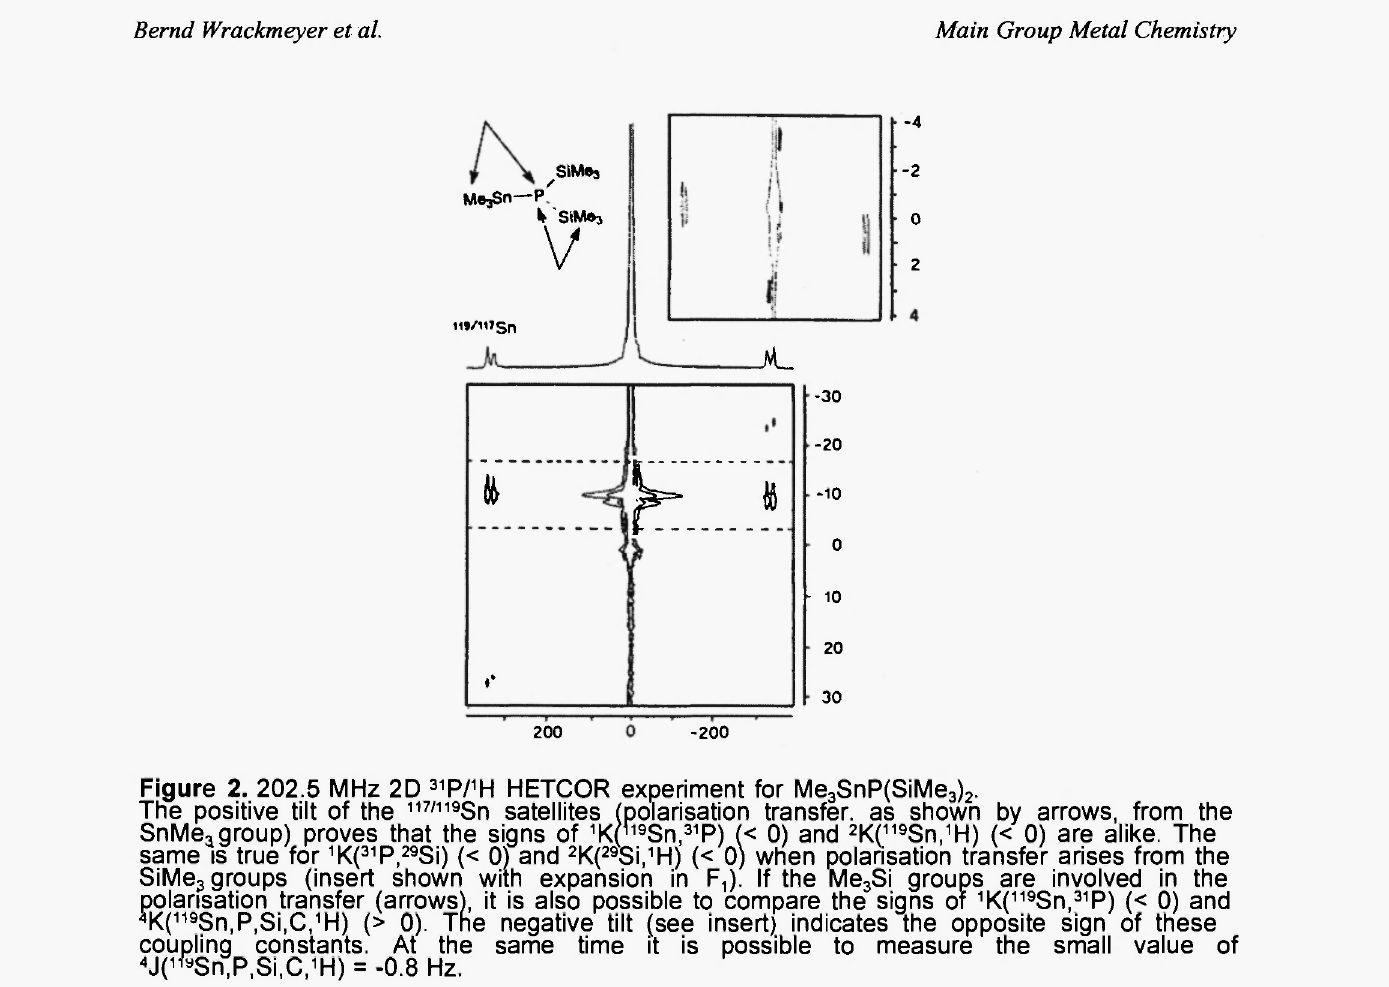
Figure 2. 202.5 MHz 2D 31 P/ 1 H HETCOR experiment for Me 3 SnP(SiMe 3 ) 2 . The positive tilt of the 117/119 Sn satellites (polarisation transfer, as shown by arrows, from the SnMe a group) proves that the signs of 1 K( ri9 Sn, 31 P) (< 0) and 2«( 119 Sn, 1 H) (< 0) are alike. The same is true for 1 K( 31 P, 29 Si) (< 0) and 2 K( 29 Si, 1 H) (< 0) when polarisation transfer arises from the